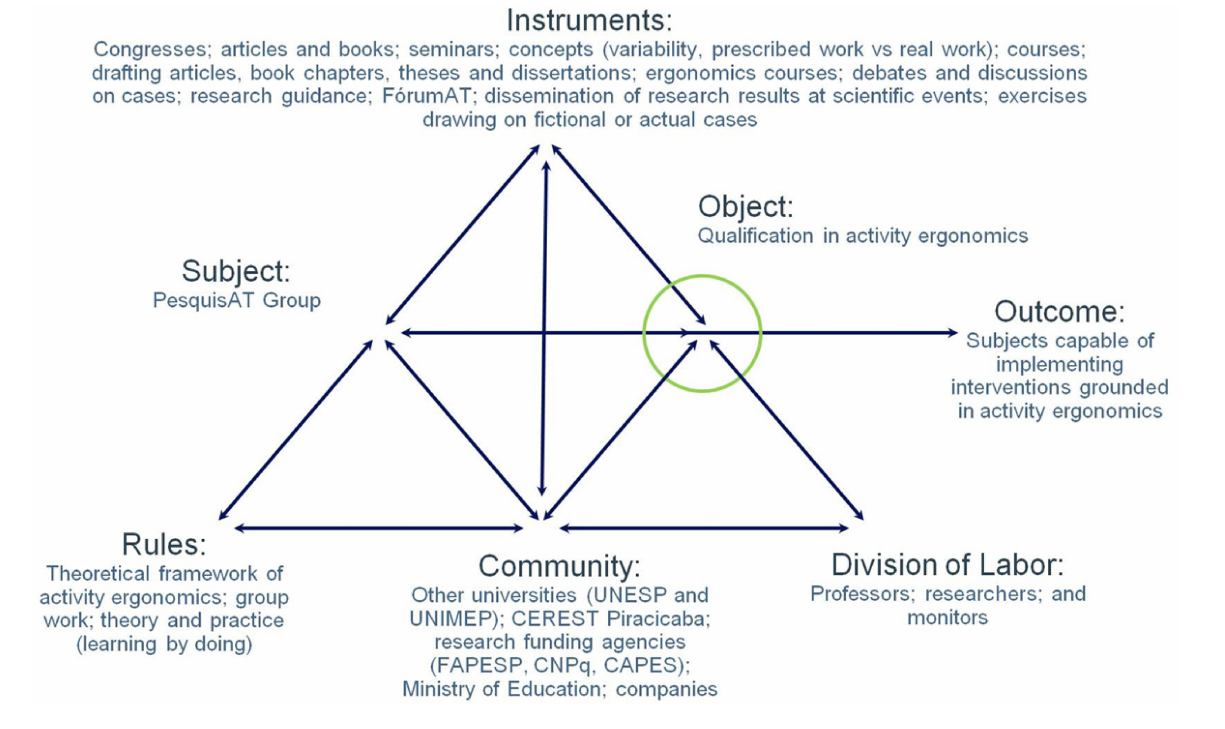
FIGURE 3 | PesquisAT’s pre-Change Laboratory learning platform